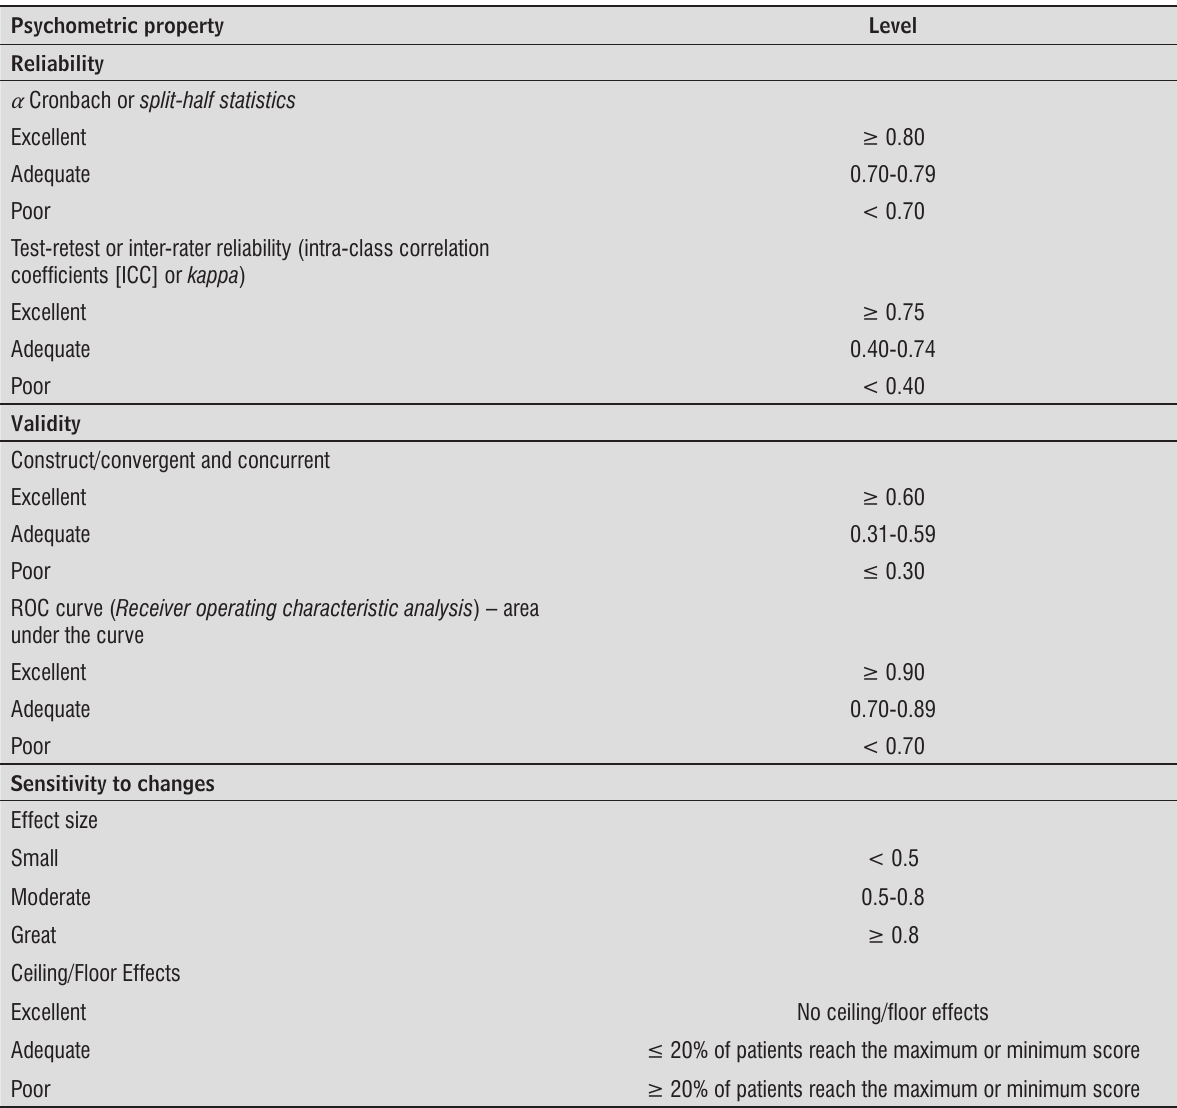
Table 1 - Statistical evaluation criteria to examine the disability assessment instruments and outcomes within research context Psychometric